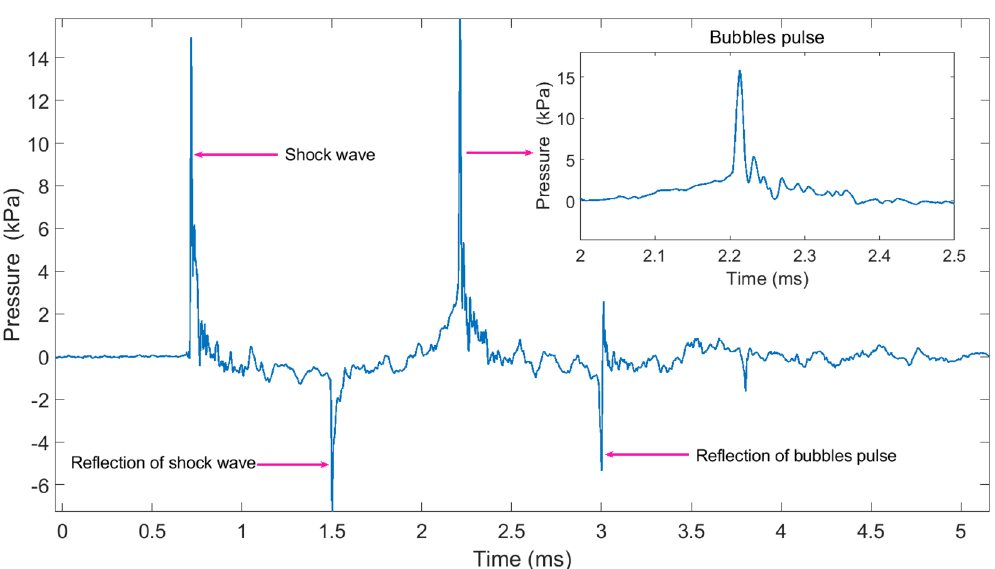
Figure 3. The total acoustic signal produced in a spark